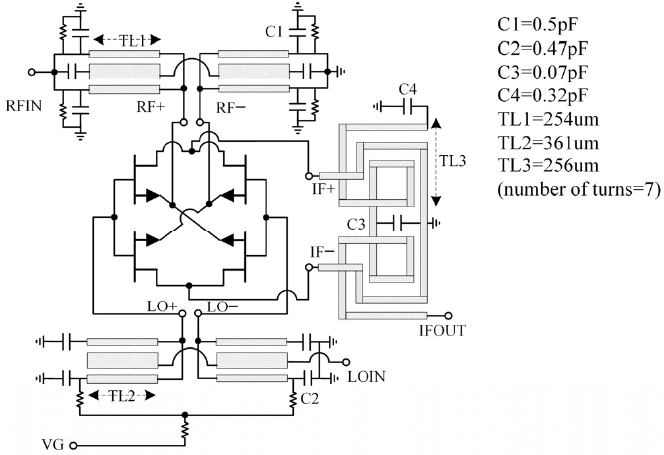
Figure 8. Circuit schematic of a double balanced mixing unit.